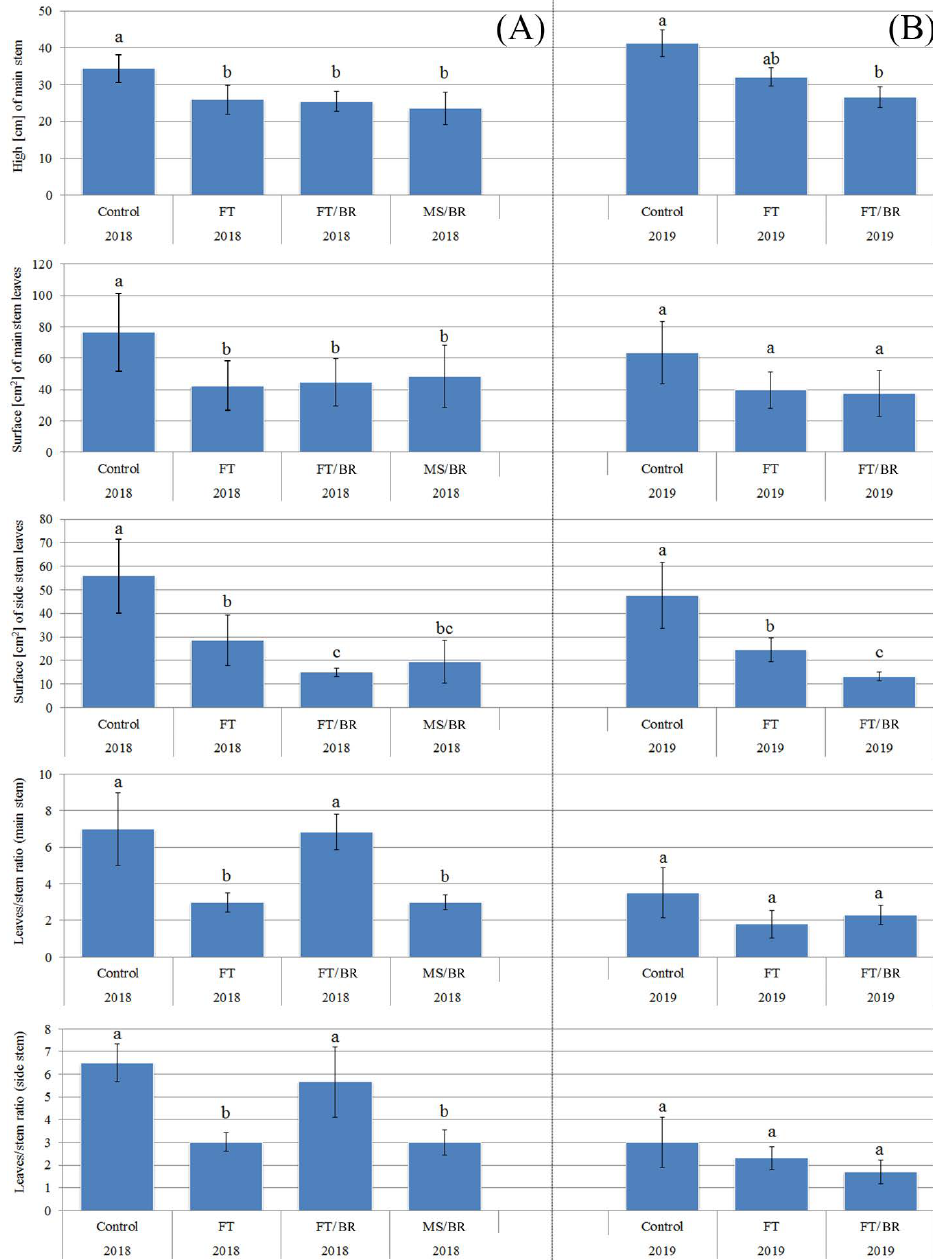
Figure 2. Characteristics of main stem height [cm], main and side stem leaves surface (cm 2 ) and leaves/stem ratio of Paulownia cultivated in particular experimental systems in the first ( A ) and the second ( B ) year of investigation (identical lettering denote no significant ( p > 0.05) differences according to a post-hoc Tukey’s HDS